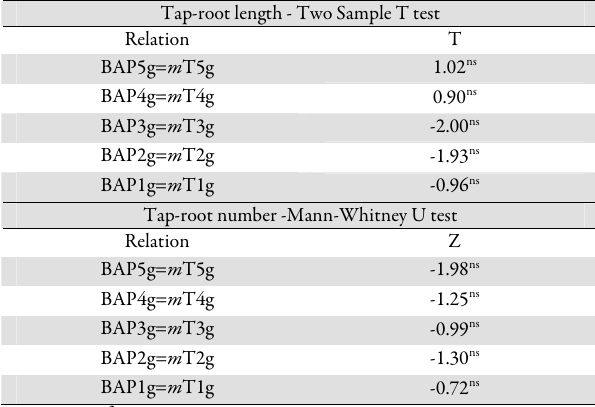
Tab. 5. The tap-root analyses between the two cytokinin treatments in rooting